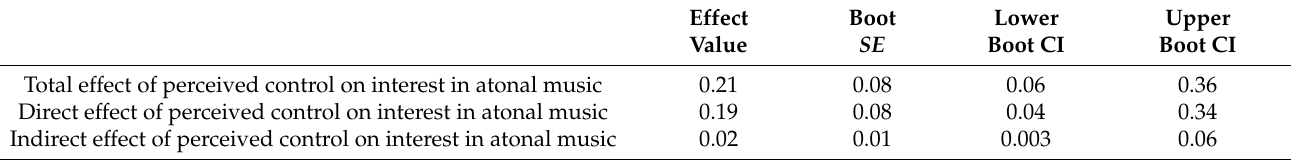
Figure 2. Mediation model of the need for structure in the relationship between perceived control and interest in atonal music. Path values are the path coefficients with standard errors. * p < 0.05. ** p < 0.01.